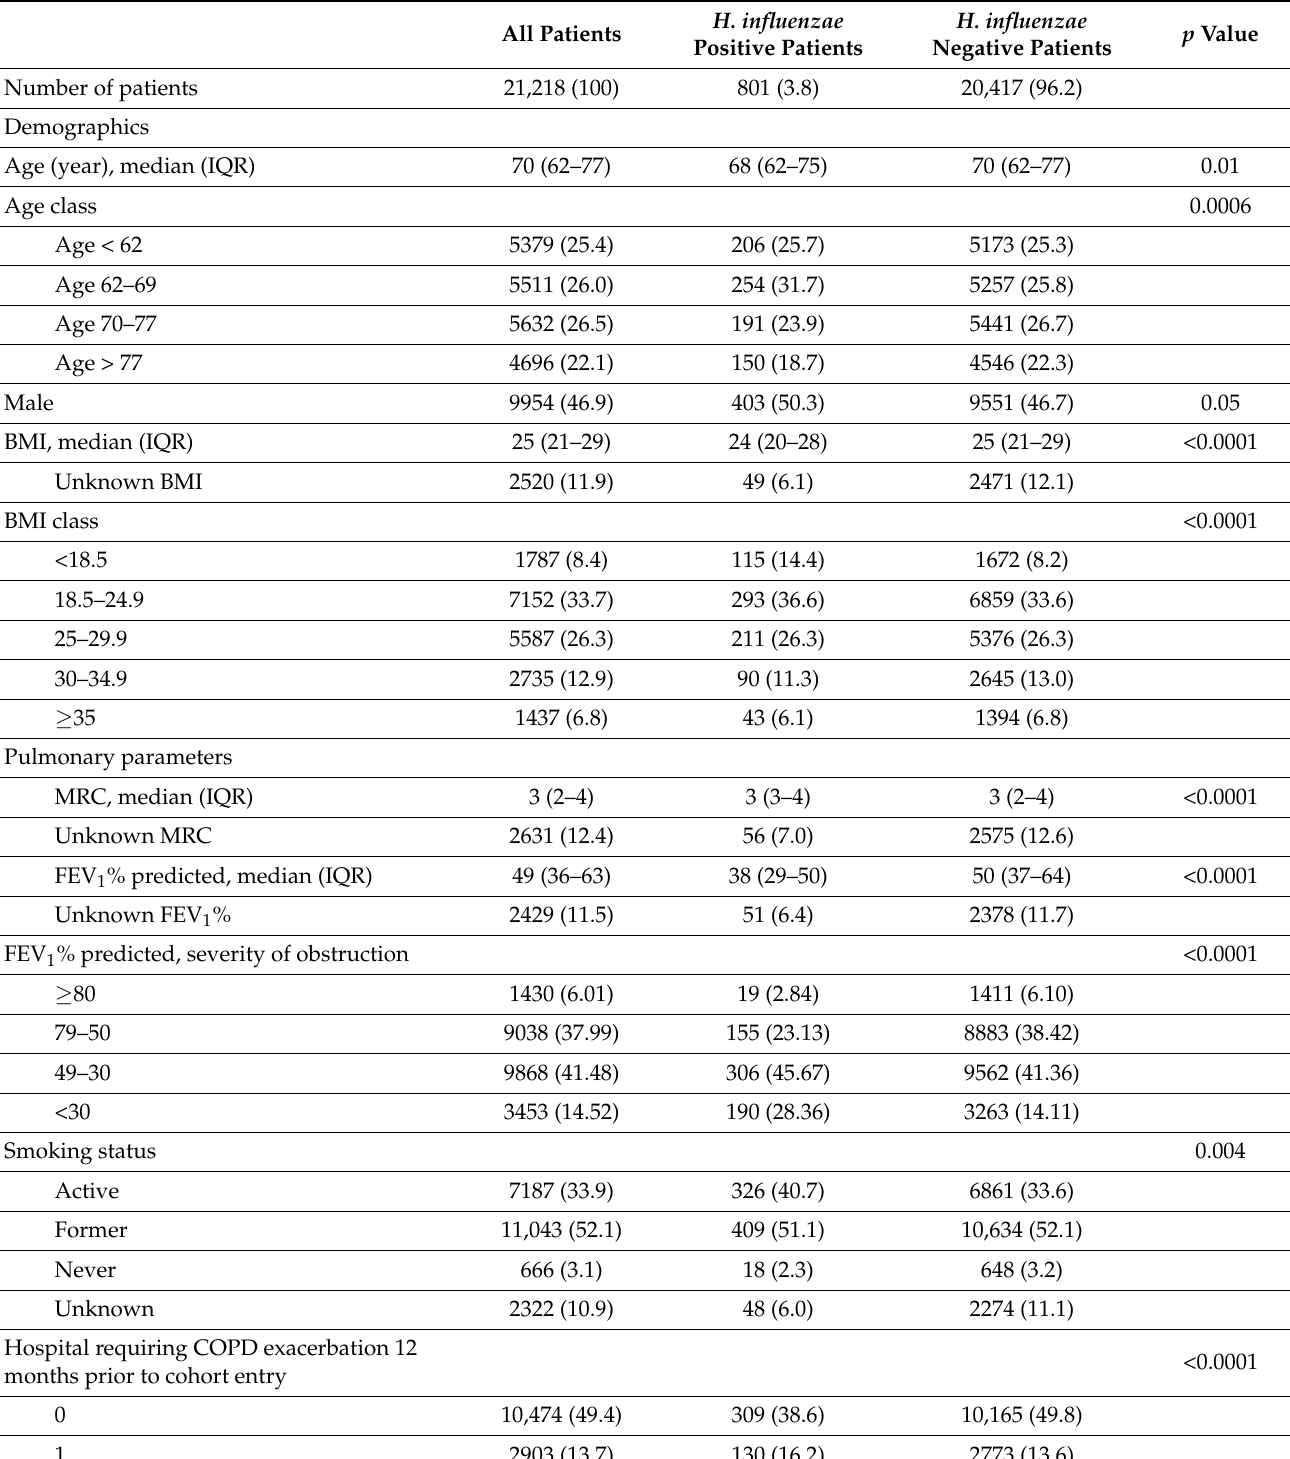
Table 1. Characteristics at cohort entry in 21,218 patients with